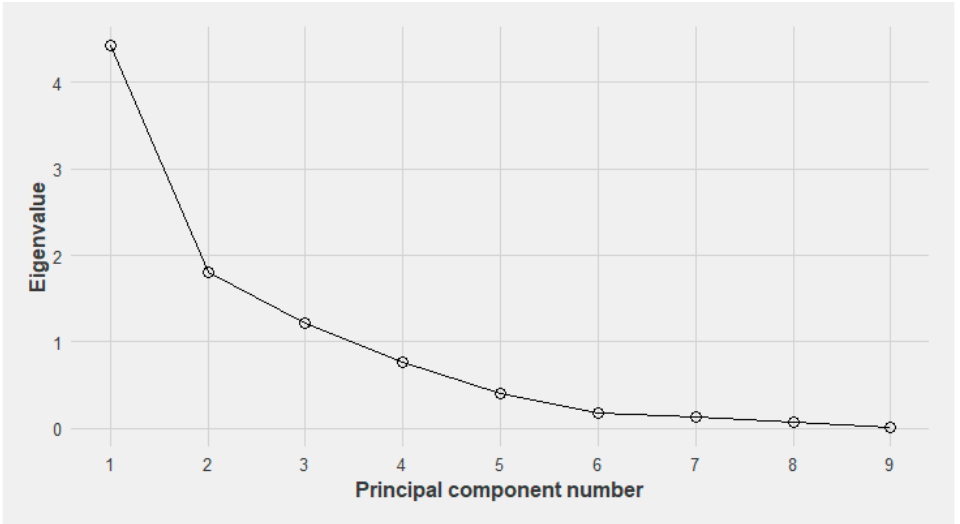
Figure 5. Screen plot of principal components.